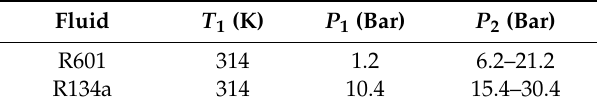
Table 4. Cycle temperatures and